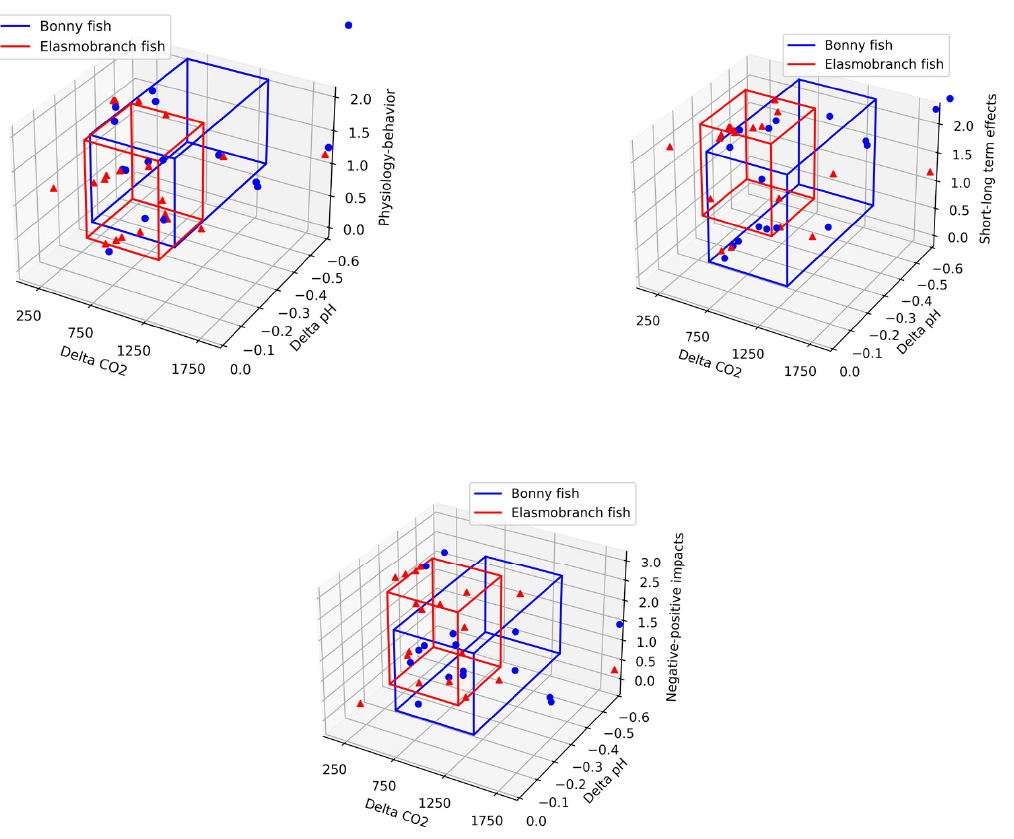
Figure 2. Equivalence between elasmobranch (red) and bony fish (blue) on the effect of expected changes in CO 2 and pH concentrations on behavior (short/long effect and negative/positive effect). Points (blue and red) on the scatter plot are the values from the review summarized table. Specifically, the CO 2 delta and pH delta are the absolute value from the control and modified columns of each type, respectively. The z-axis represents 0 for the short term, 1 for the long term, and 2 for the short + long term. The boxes encompass the center around the mean of the data (on all three dimensions) and the length of each side corresponding to 2 STD. As a result, the boxes represent the area of statistical significance for alpha = 0.05.